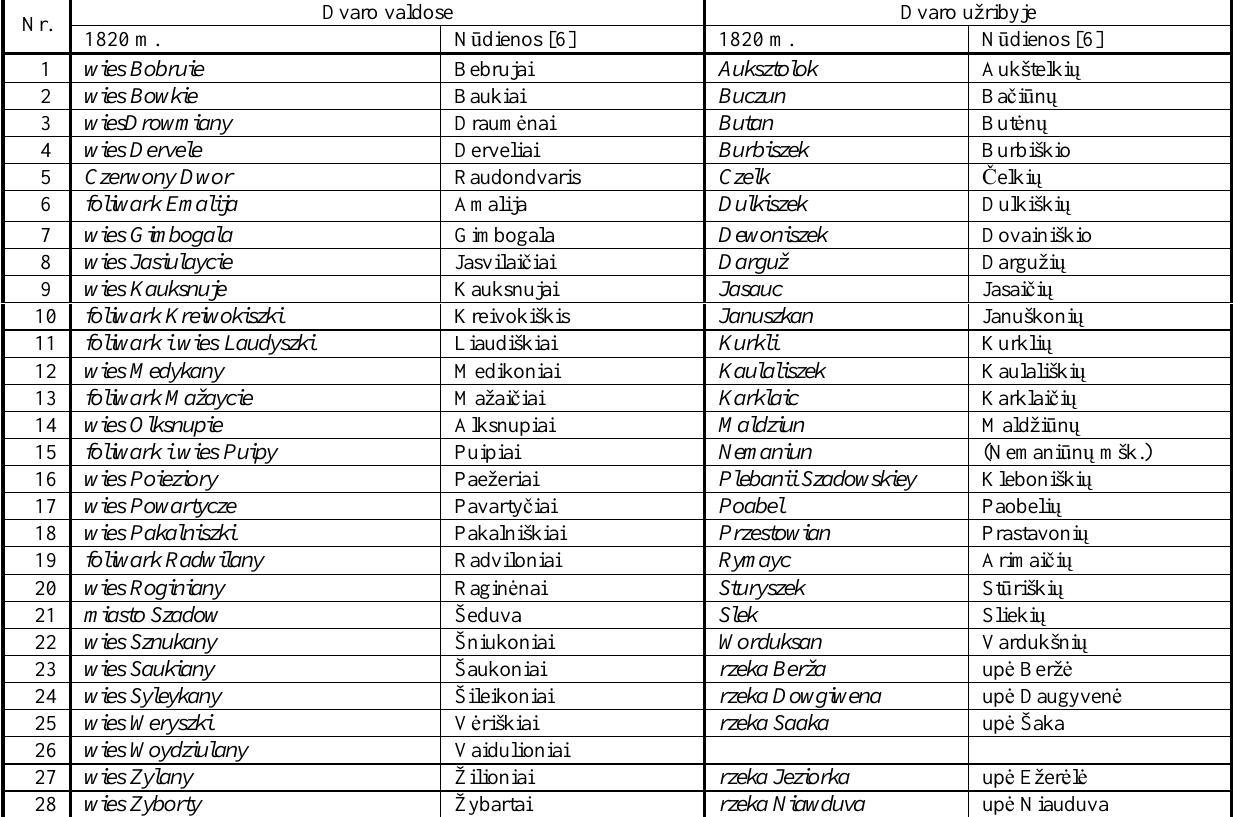
Table 1 . Names of the toponyms and hydronims in the plan of land estates of Šeduva Dvaro valdose Dvaro užribyje Nr. 1820 m.